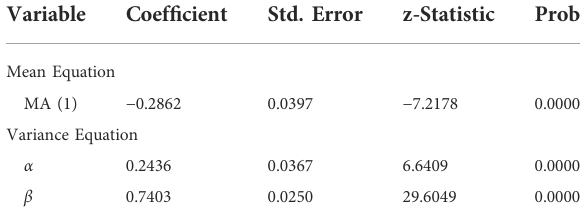
TABLE 10 Parameter estimates of the MA (1) — GARCH (1, 1) model for Hubei spot returns without structural breaks from 1 July 2019, to